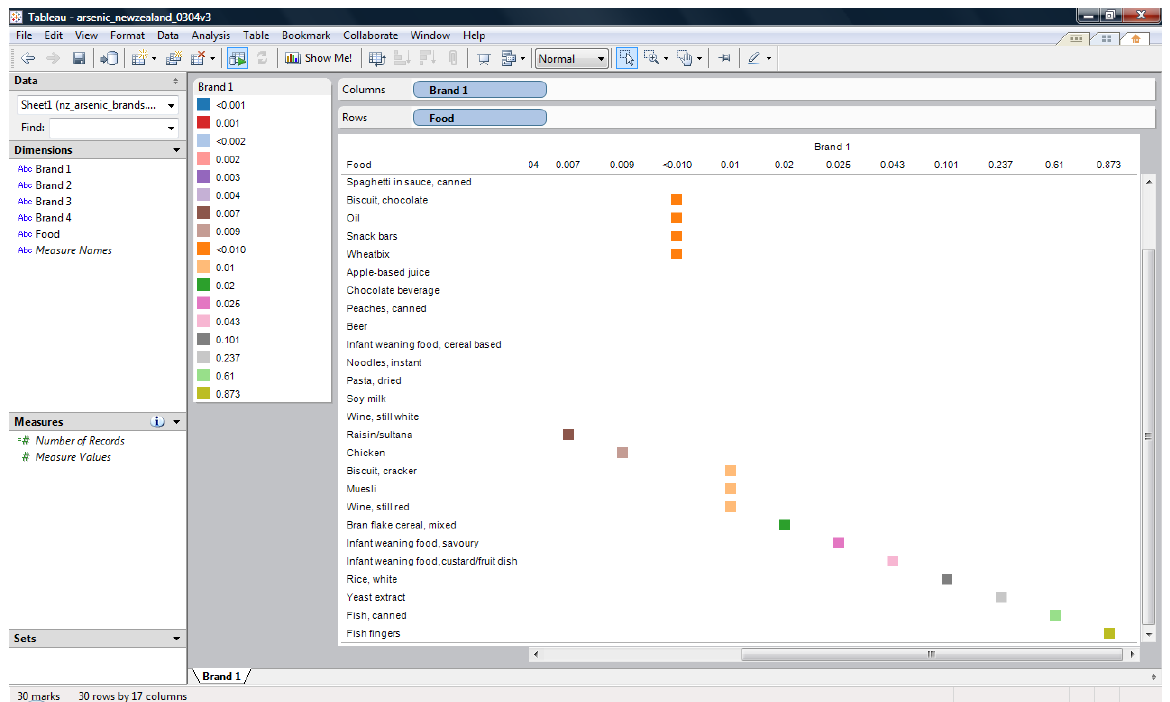
Figure 3. Screenshot of visual analytics of arsenic content (mg/kg) of food from a study in New Zealand a